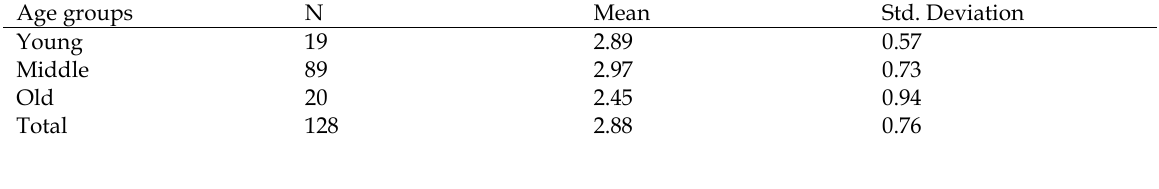
Table 2. Summary of the perceived accessibility at Greenwood Station. Perceived accessibility ranges from 1 (inaccessible) to 5 (extremely